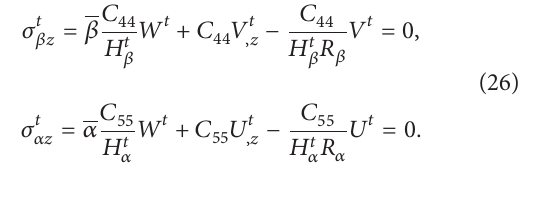
Equation (23) imposed at the bottom of the structure has 𝑅 𝛼 , 𝛼 , and 𝛽 calculated in the midsurface Ω 𝑅 𝛽 , 𝐻 𝑏 𝐻 𝑏 𝛼 and 𝛽 are calculated at the bottom of the shell for